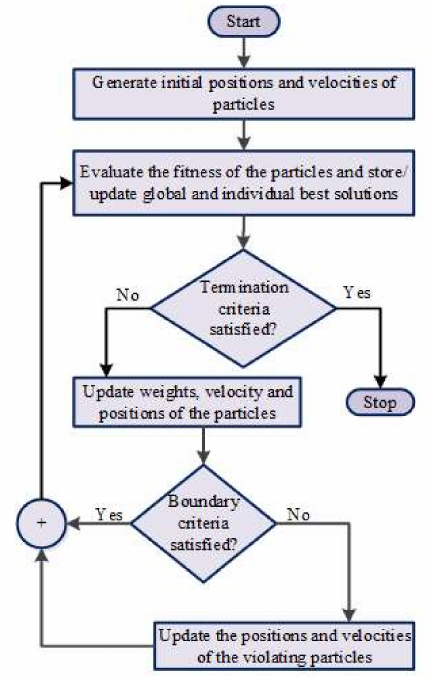
Figure 4. Flowchart of particle swarm optimization